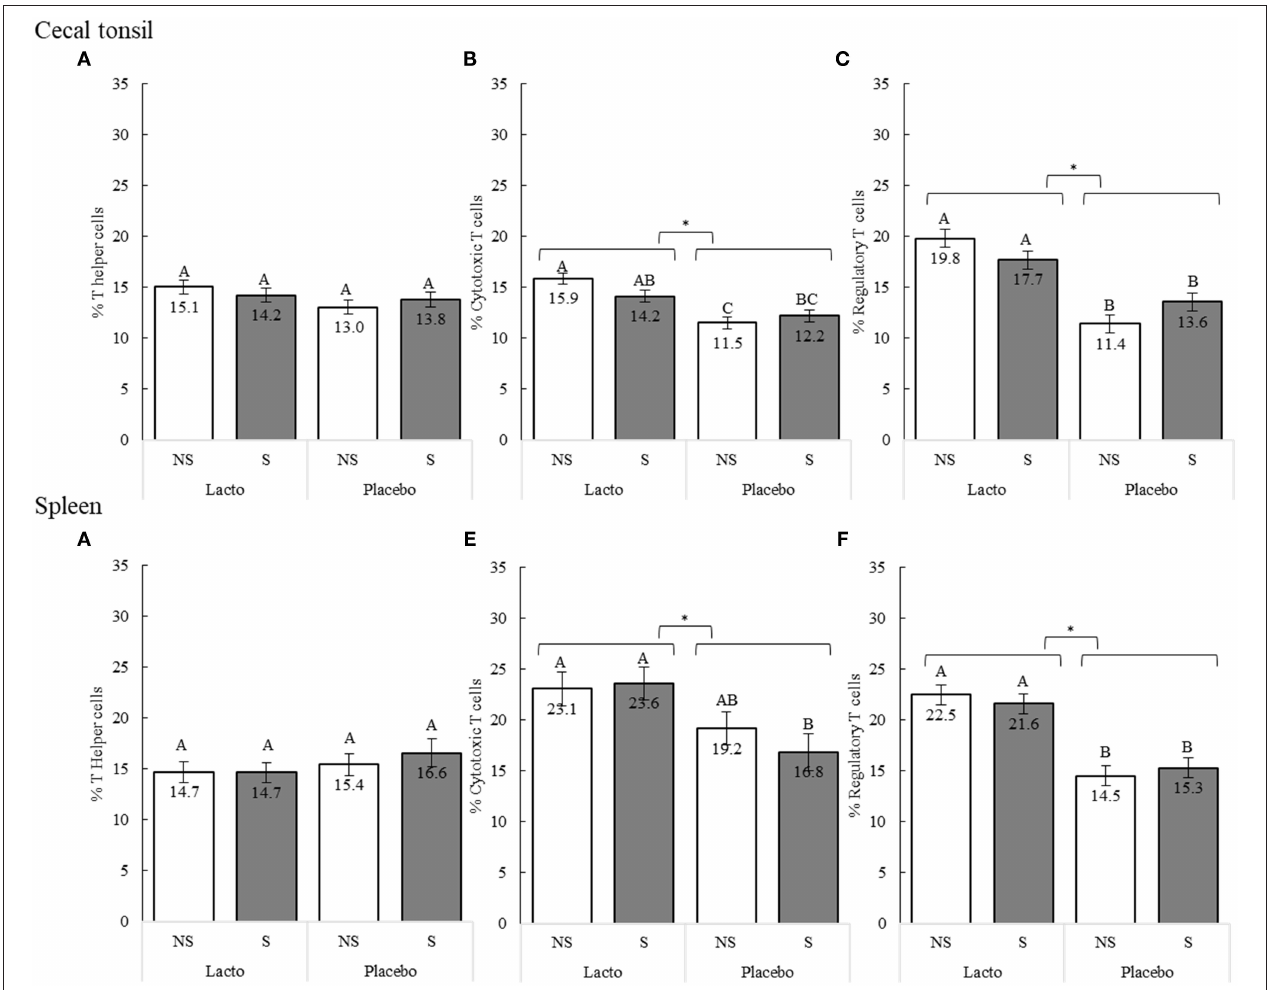
FIGURE 2 | Proportions of T cell sub-populations in the cecal tonsils (A–C) and spleen (D–F) of 38-weeks old birds after 5 weeks of supplementation ( L. rhamnosus [Lacto] or water [Placebo] supplementation, 33–38 weeks of age) and 3 weeks of stress treatment (non-stressed [NS] or stressed [S], 33–35 weeks of age). Sub-populations were identified using the following combinations of cell surface markers: T helper cells = CD3 + CD4 + ; cytotoxic T cells = CD3 + CD8 + ; T regulatory cells = CD4 + CD25 + (n of birds: S-Placebo = 15, NS-Placebo = 15, S-Lacto = 15, NS-Lacto = 15). Different superscript letters indicate statistically significant differences between specific supplement and stress treatment comparisons of the interaction, and * indicates statistically significant differences of the supplementation treatment as a main effect ( P <